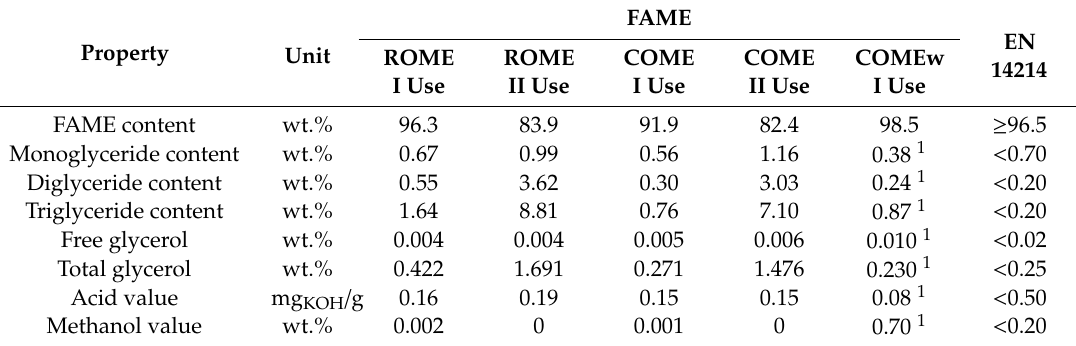
Table 5. Chemical properties of ROME, COME, and COMEw. [Molar ratio methanol-to-oil ratio of 6:1; amount of catalyst KOH / AC = 1.5 wt.%; reaction time, 4